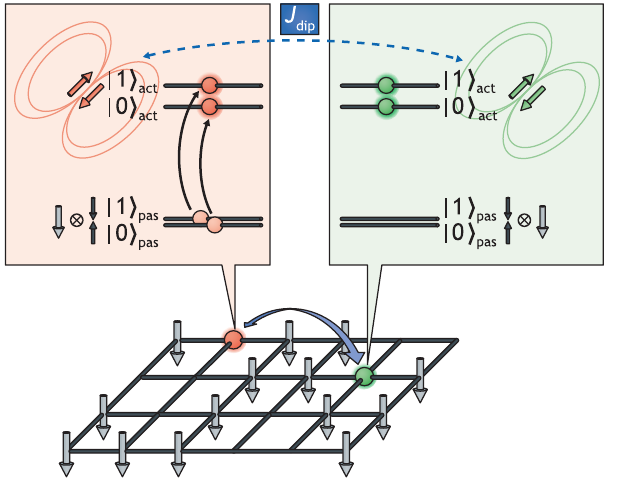
FIG. 1. Basic principle of the quantum computing scheme. The passive (memory) qubit consists of nuclear degrees of free- dom in the presence of polarized electronic RE spins. Even though the electronic spins create substantial internal fields, they are much smaller than the external field, such that the electronic system remains in its gapped, fully polarized ground state and spin flips are suppressed. The nuclear qubits can be selectively activated by optical excitation to a (locally tunable) electronic CF doublet with a large magnetic moment. Two activated qubits communicate via the electronic (magnetic) dipolar interaction, allowing for fast two-qubit gates over distances of several 10 nm, as long as the dipolar interaction is sufficiently strong as com- pared with the inverse lifetime of the active qubits. This enables gates between non-nearest neighbors.